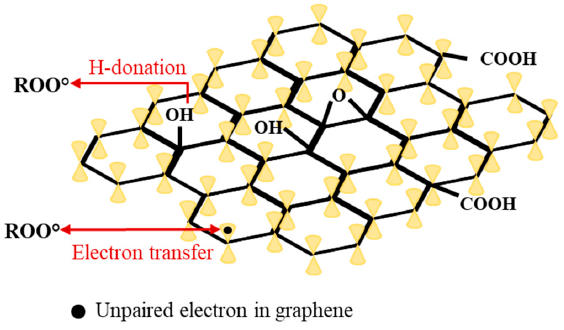
Figure 5. Radical adduct formation at the sp 2 carbon sites and H-donation from hydroxyl groups